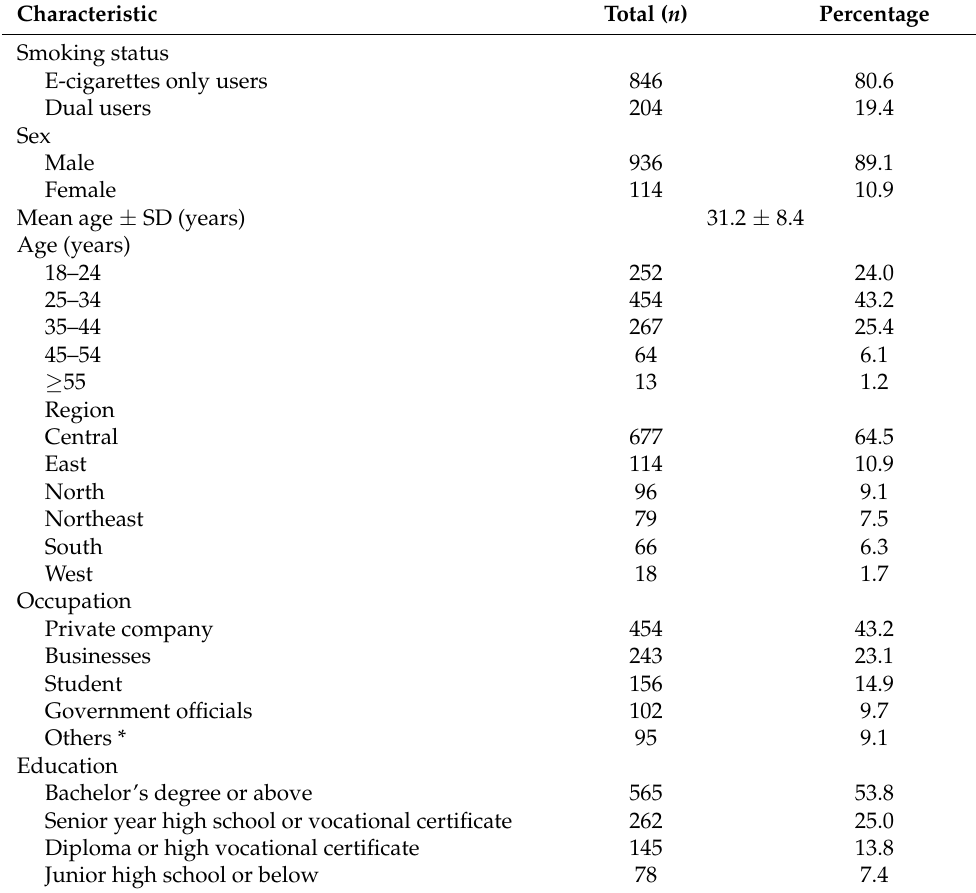
Table 1. Characteristics of e-cigarettes users ( n =